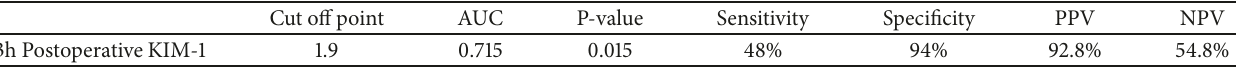
Table 4: Performance characteristics of urinary KIM-1 3 h after